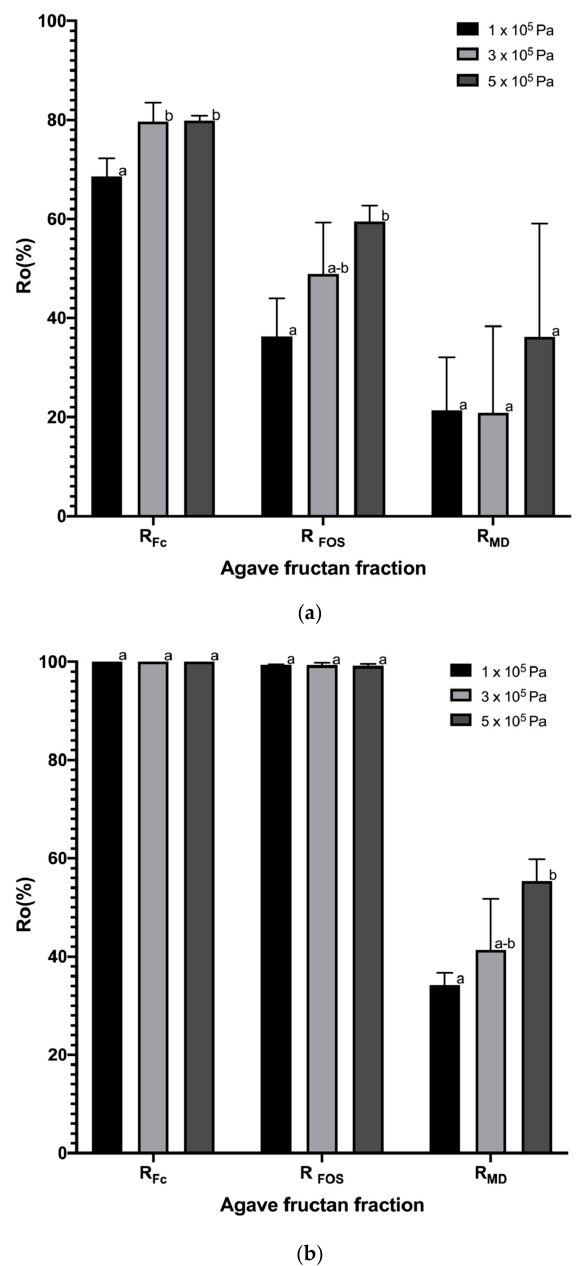
Figure 5. Observed rejection coefficient of agave fructan fraction: fructans with DP ˃ 10 (Fc), fructooligosaccharides (FOS), mono-disaccharides (MD), using a ceramic membrane system ( a ) and polymeric membrane system ( b ) as functions of applied transmembrane pressure. a-b Different superscripts within the same column indicate that the means differ significantly ( p ˂ 0.05).